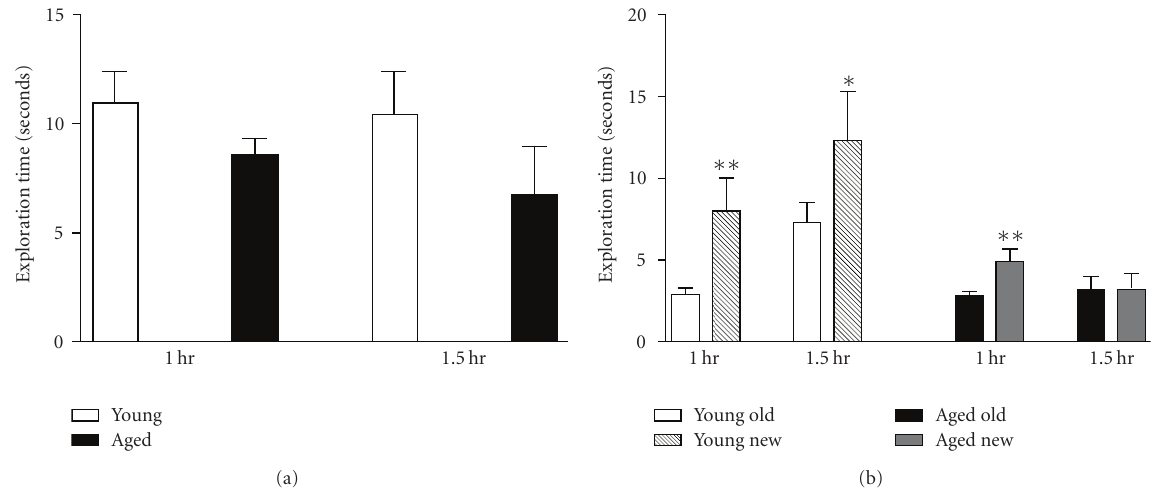
Figure 2: (a) Object placement-exploration time during the sample trial. Mean exploration time ± SEM for young ( n = 8) and aged rats ( n = 9) prior to 1- and 1.5-hour intertrial delay trials. No significant di ff erences by two-way ANOVA (group × trial). (b) Object placement-exploration time during the retention trial. Mean exploration time ± SEM at old and new locations is shown for 1- and 1.5- hour intertrial delay trials for young ( n = 8) and aged ( n = 9) rats. Data analyzed by three-way ANOVA, group × location × delay: group e ff ect ( F (1,76) = 19 . 36, P < 0 . 0001) indicated that the young group explored the objects more than the aged group; location e ff ect ( F (1,76) = 9 . 81, P < 0 . 002) and a group × location interaction ( F (1,76) = 4 . 06, P < 0 . 04). Post hoc di ff erences tested by paired t -tests where ∗ P < 0 . 05, ∗∗ P < 0 . 01.